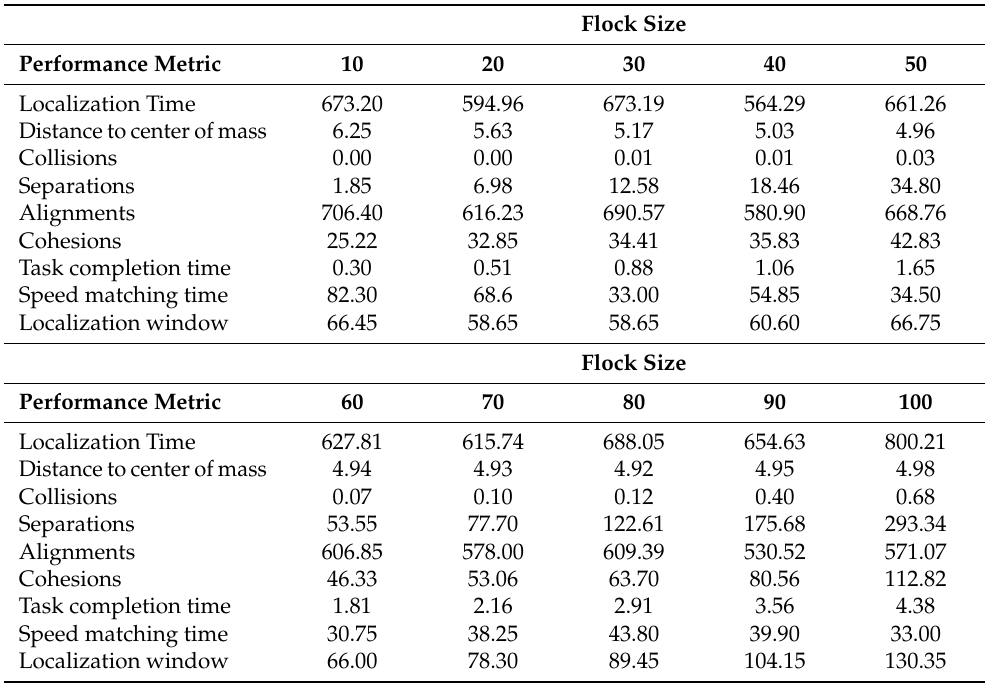
Table 3. Performance metric results averaged over twenty simulations for flock sizes in 10–100, in an environment without